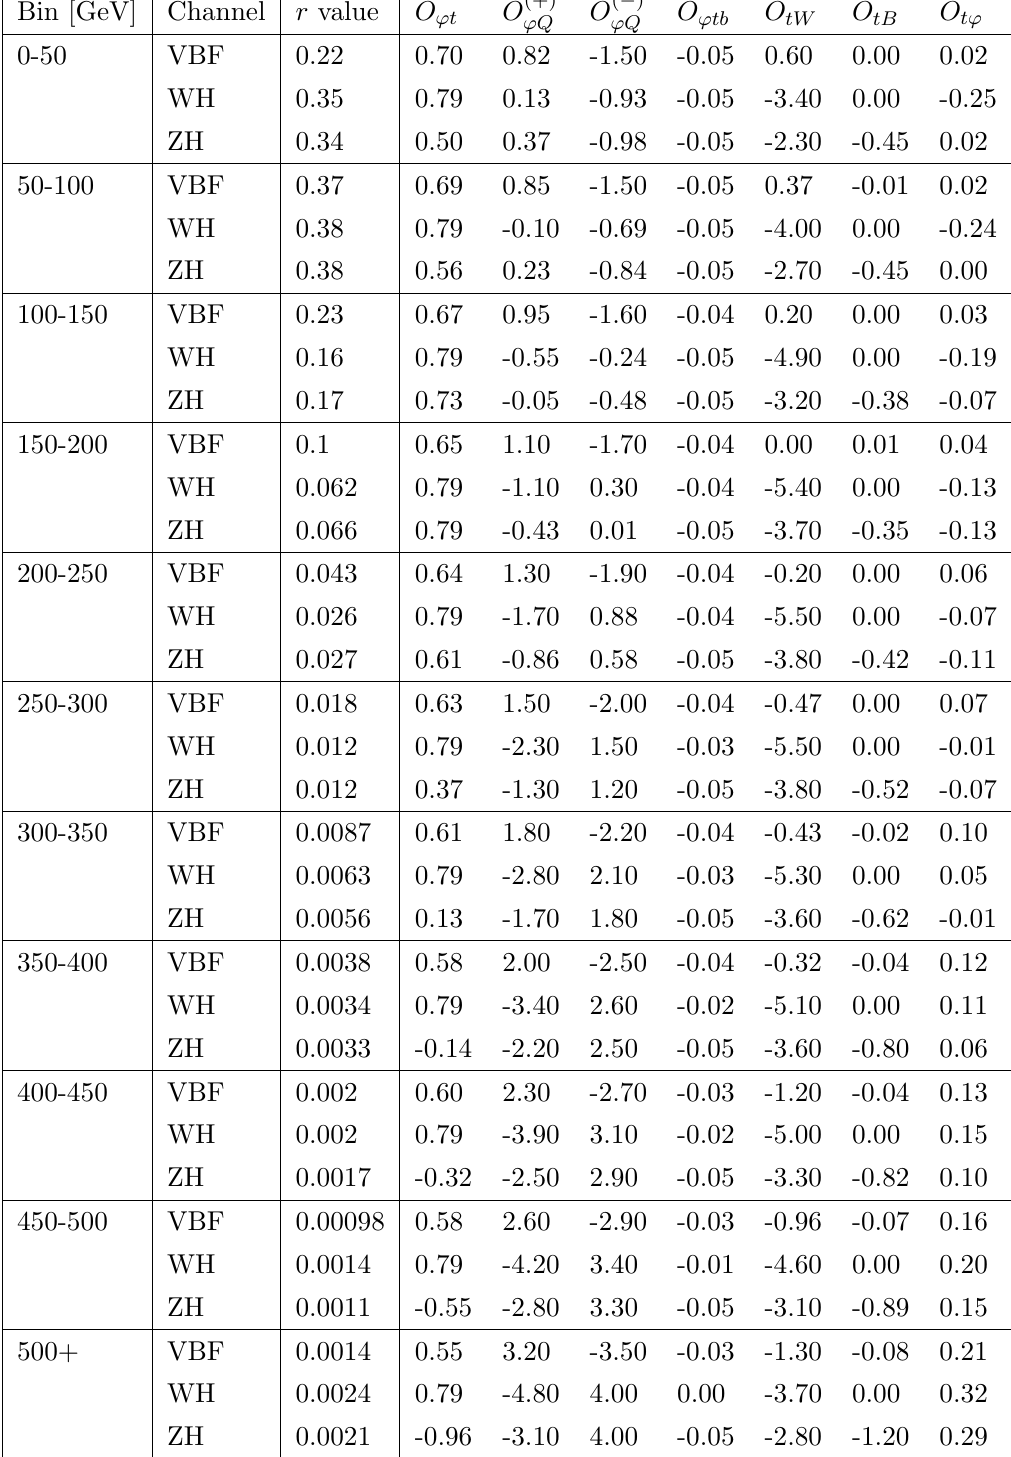
Table 17 . r values and percentage deviations (cid:22) ij for VBF, WH and ZH production in 11 bins of the p T ( H ) distribution at (cid:22) EFT = 1